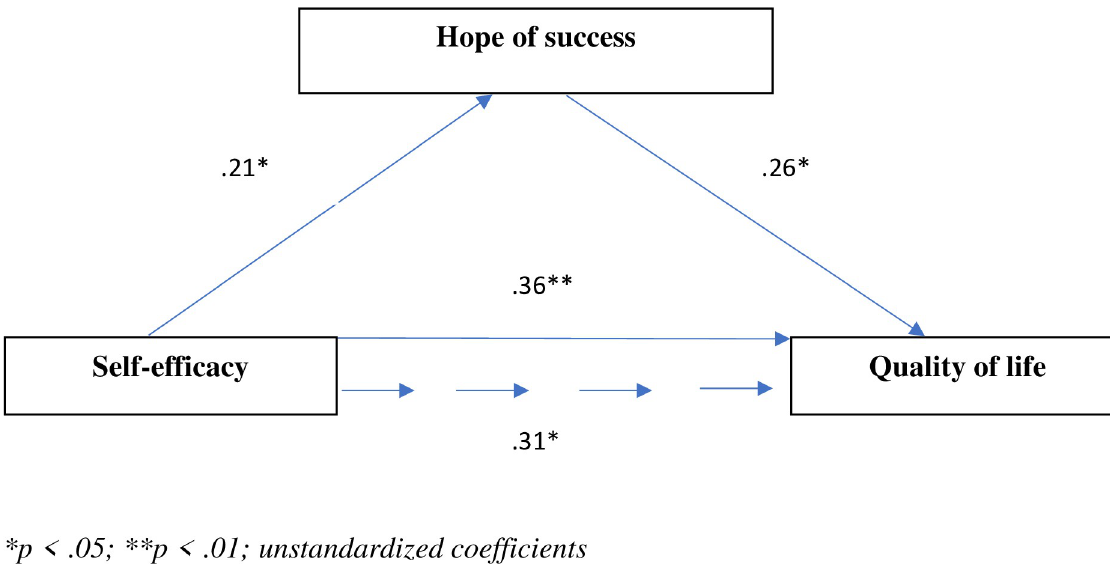
Fig 4. Model of relationships between general self-efficacy, hope of success, and quality of